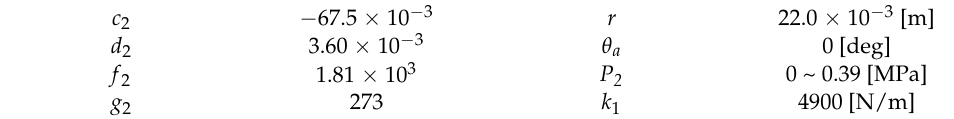
Table 1. Parameter values of the one-sided spring antagonized joint [18–20].